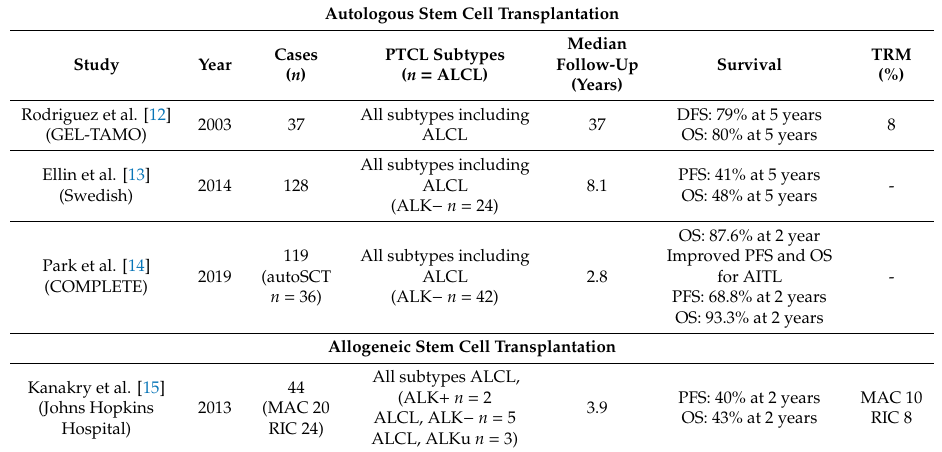
Table 3. Autologous and allogeneic stem cell transplantation in the frontline setting: registry data. Autologous Stem Cell